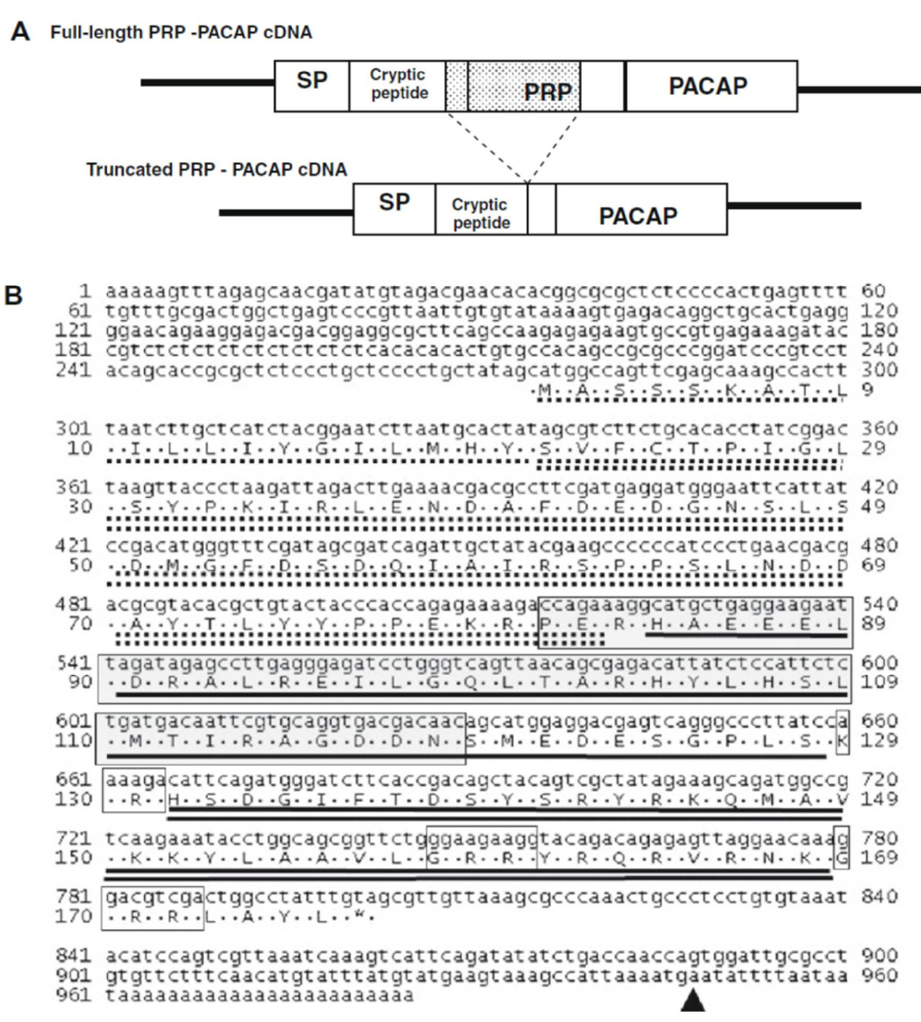
Figure 18. Schematic structures and sequences of PRP–PACAP. ( A ). Schematic structures of the prepro PRP–PACAP cDNA of blue gourami. ( B ). cDNA sequence of PRP–PACAP. The signal peptide is underlined with a dashed black line; the cryptic peptide is underlined with a dashed double line; the PRP sequence is underlined in black; the cleavage-site positions are boxed and the PACAP sequence is double-underlined. The gray box designates the deleted re- gion in the PRP–PACAP short form. The triangle denotes the 3’ poly(A) signal ATTAAA [31,33,36].